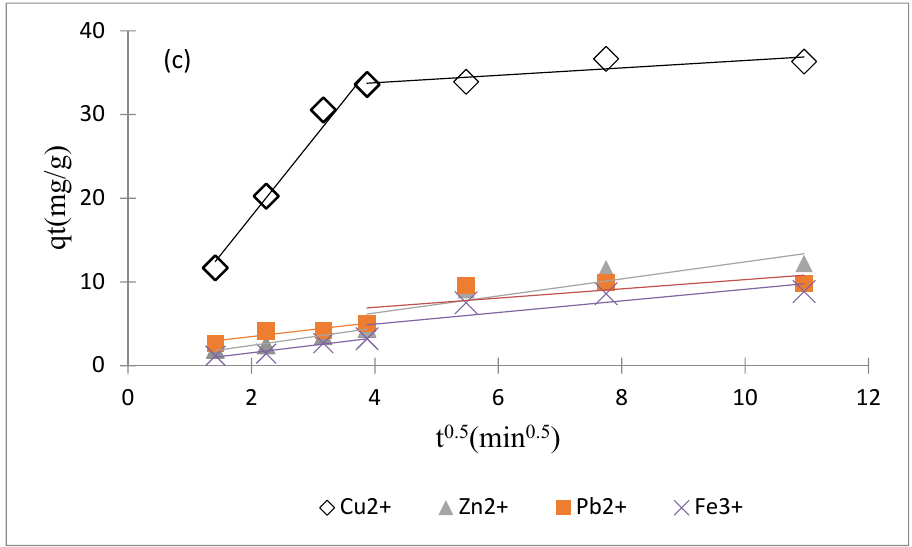
Figure 7. Intraparticle diffusion kinetics for adsorption of Cu 2+ , Zn 2+ , Pb 2+ , and Fe 3+ onto IIP/Mt nanocomposites.